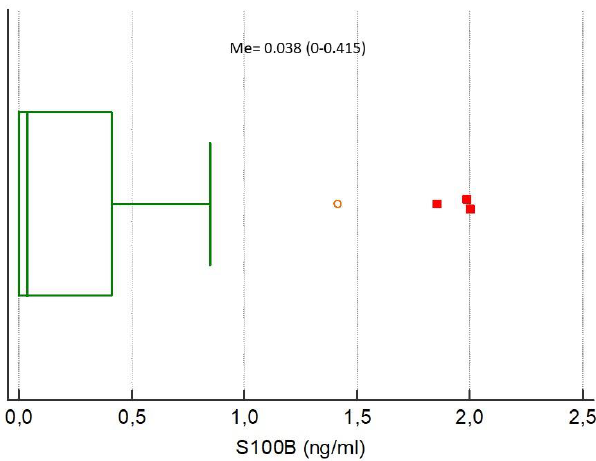
Figure 4. Distribution of the S100 calcium-binding protein B (S100B) concentrations in the study population. Circles and squares indicate outliers and far out values illustrated as single data points.